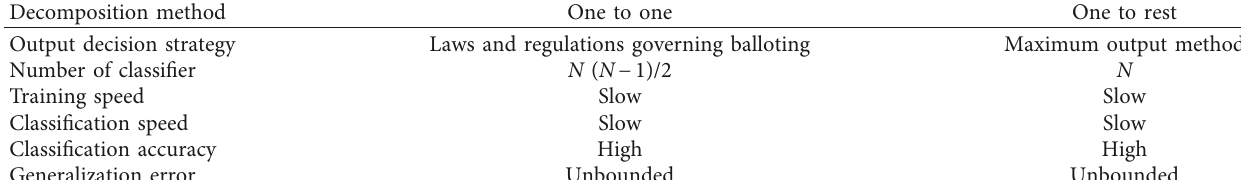
Table 1: Comparison of SVM methods.